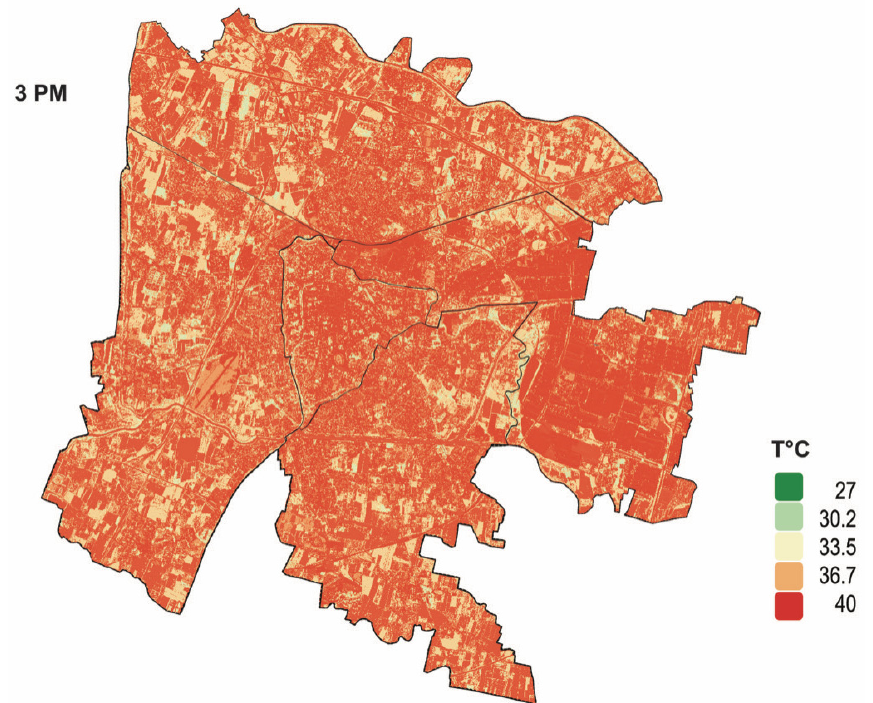
Figure 4. Simulated temperature distribution in the 10 m × 10 m units in the daytime at 3 p.m. (35 °C at the reference weather station).